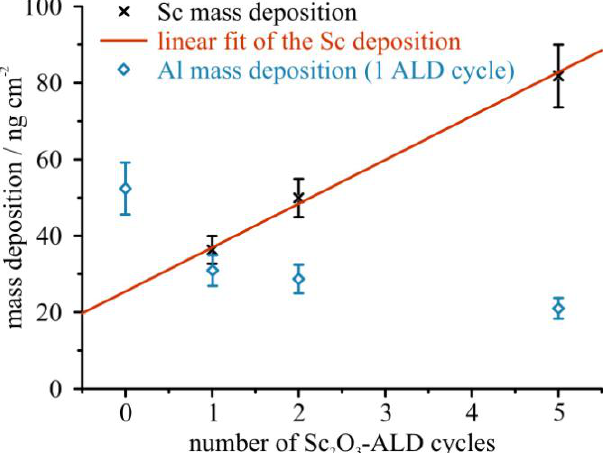
Figure 6. Quantified Sc and Al mass deposition plotted over the number of Sc-ALD